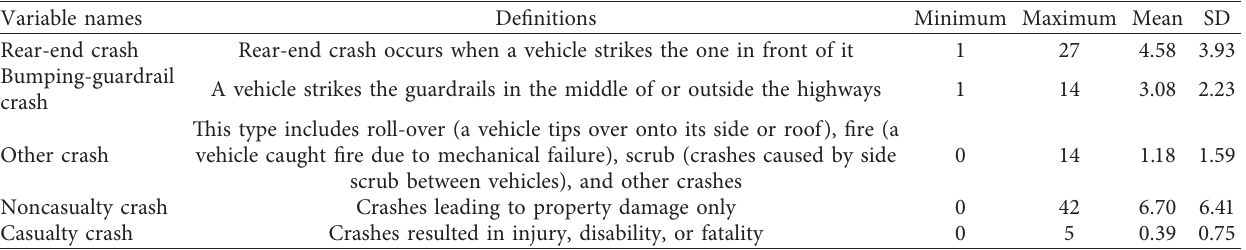
Table 1: Descriptive statistics of dependent